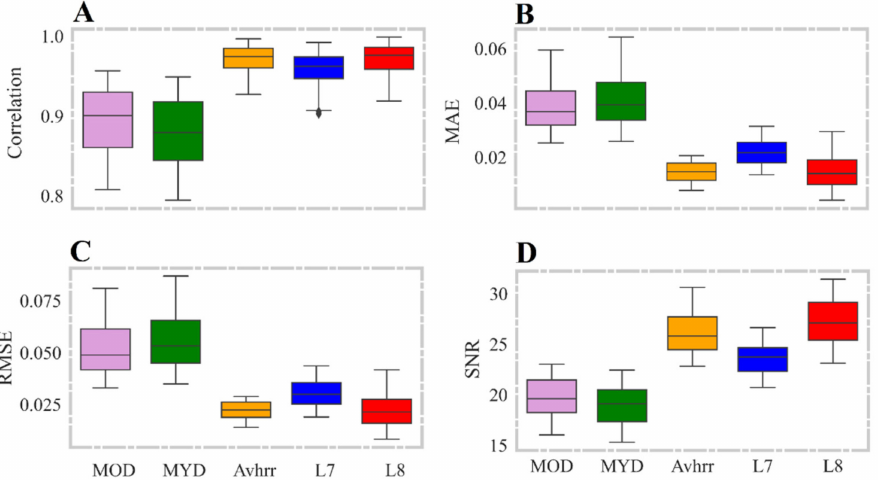
Figure 8. Boxplots of the overall sensor performance for the five sensors. ( A ) Correlation coefficient between original and modeled NDVI time series (CC); ( B ) mean absolute error (MAE); ( C ) root mean square error (RMSE); ( D ) signal to noise ratio (SNR). The box-plot diagrams report the sample minimum, lower quartile, median, upper quartile, sample maximum, and outliers.